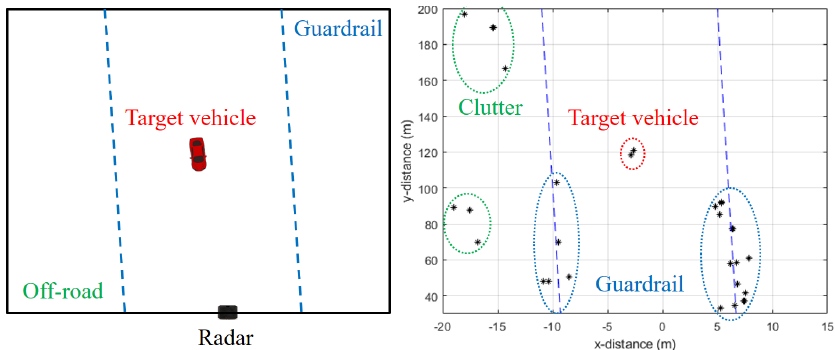
Figure 7. Target detection result in the Cartesian coordinate